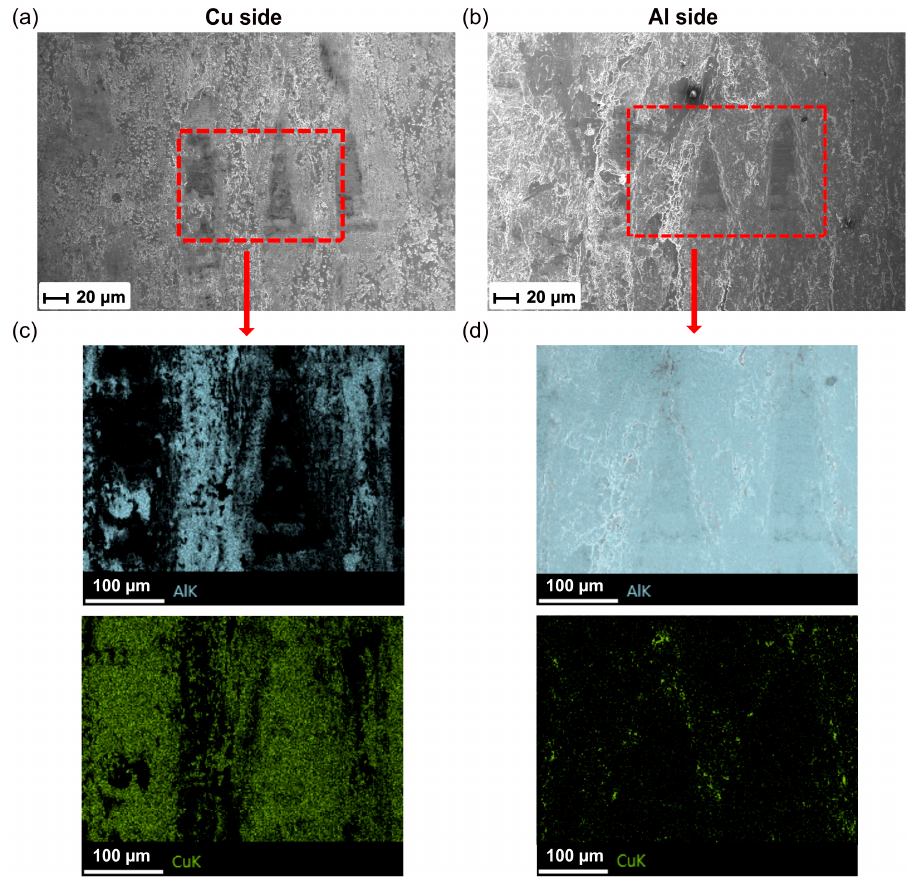
Figure 14. ( a , b ) SEM images of the fracture morphology for the Al/Cu joint in Region II, and ( c , d ) EDS maps of selected region.